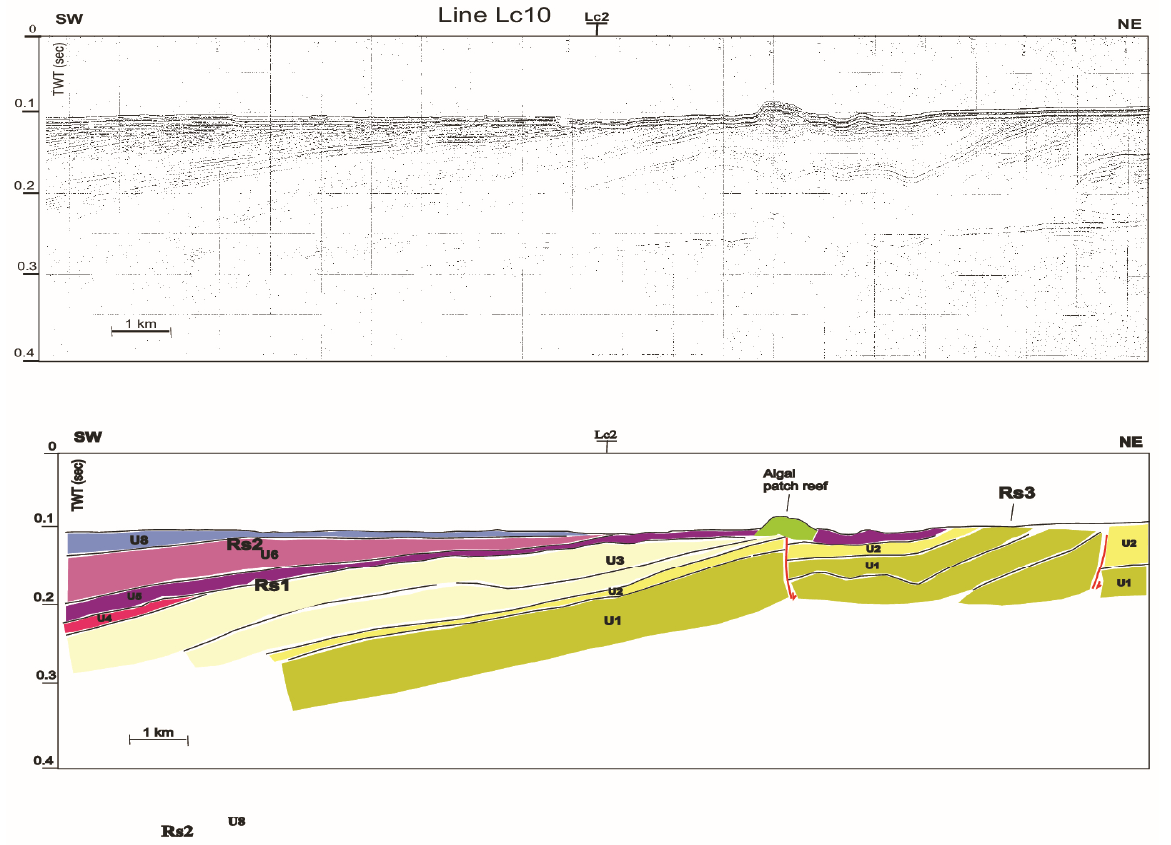
Figure 11. The section LC10 crosses a structural high of the forced regression prograding wedge W1 (units U1–U4), as also evidenced by normal faulting involving the units. The ravinement surface RS1 truncates the wedge W1, while the prograding wedges W2 and W3 are significantly reduced in thickness in this area. Algal patch reefs overlying the present-day sea bottom are represented by mounded ‐ shaped chaotic morphologies.